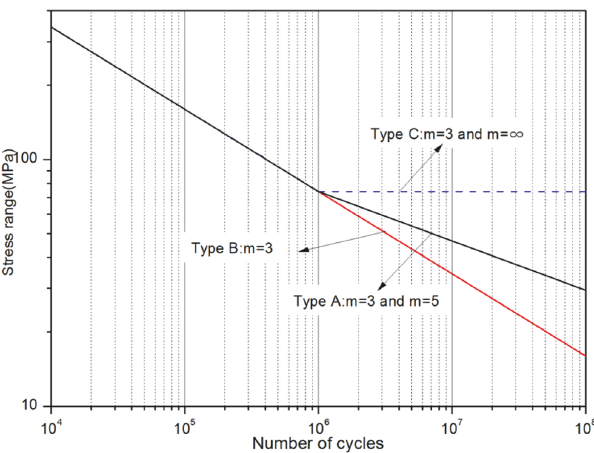
Figure 1: Example of S - N curve according to DNV